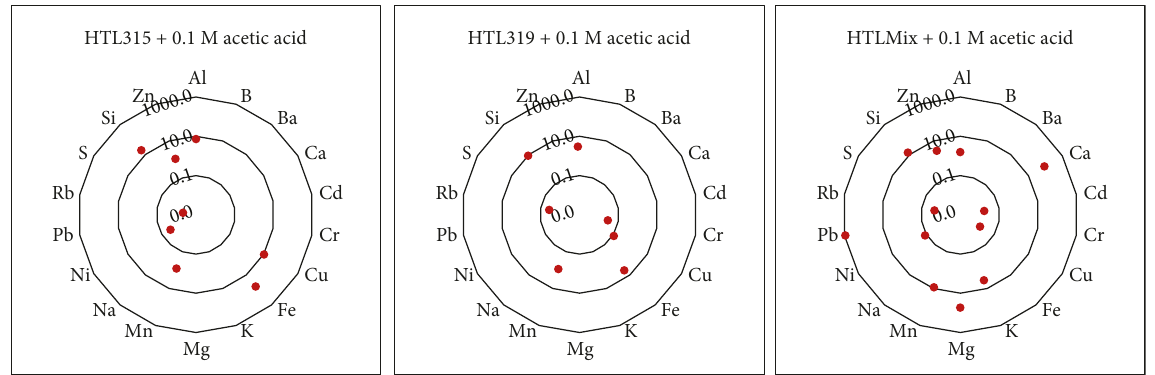
Figure 6: Elemental composition (in ppm) of each leachate reacted with 0.1M acetic acid at 70 ° C temperature under 1bar pressure in batch rotating shakers after 720 hours (absence of data points re fl ects concentrations below the limits of